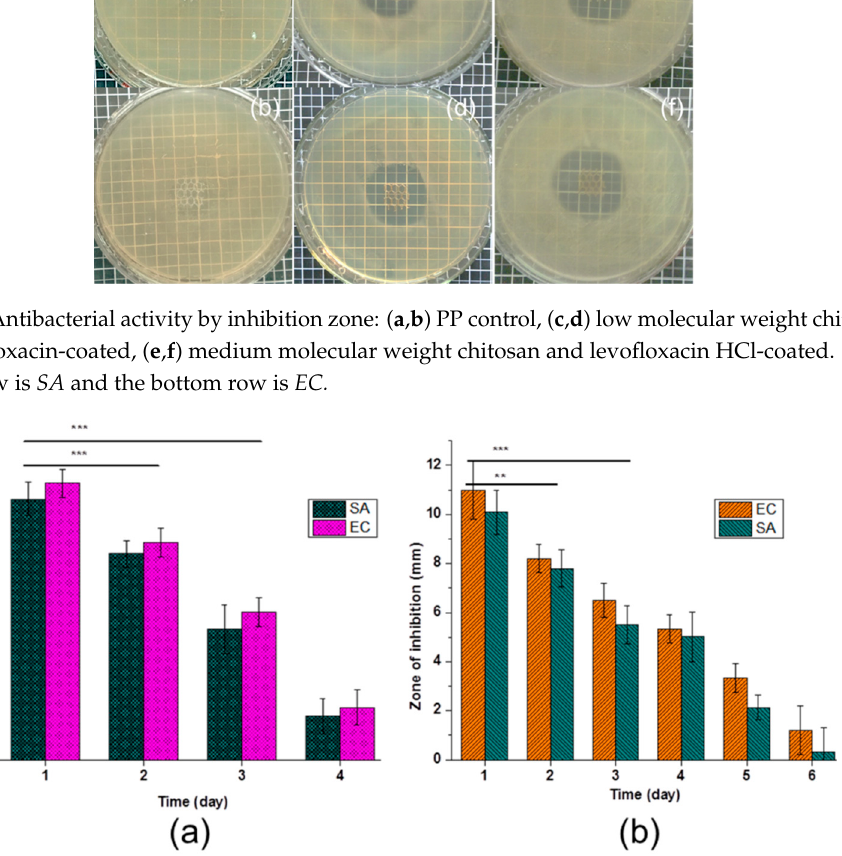
Figure 8. Antibacterial activity by release method ( a ) low molecular weight chitosan and levofloxacin coated CH ‐ LMW ( b ) Medium molecular weight and levofloxacin HCL coated PP meshes (CH ‐ MMW).